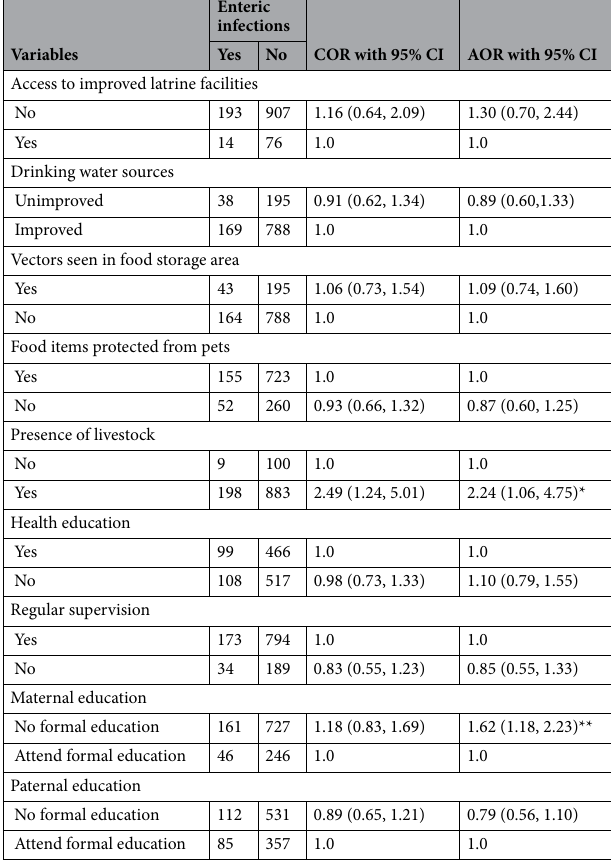
Table 4. Factors associated with enteric infections among households (n = 1190) in a rural setting of northwest Ethiopia, May 2016. *statistically significant at p < 0.05,** statistically significant at p < 0.01, Hosmer and Lemeshow test: 0.238, AOR Adjusted odds ratio, CI Confidence interval, and COR Crude odds